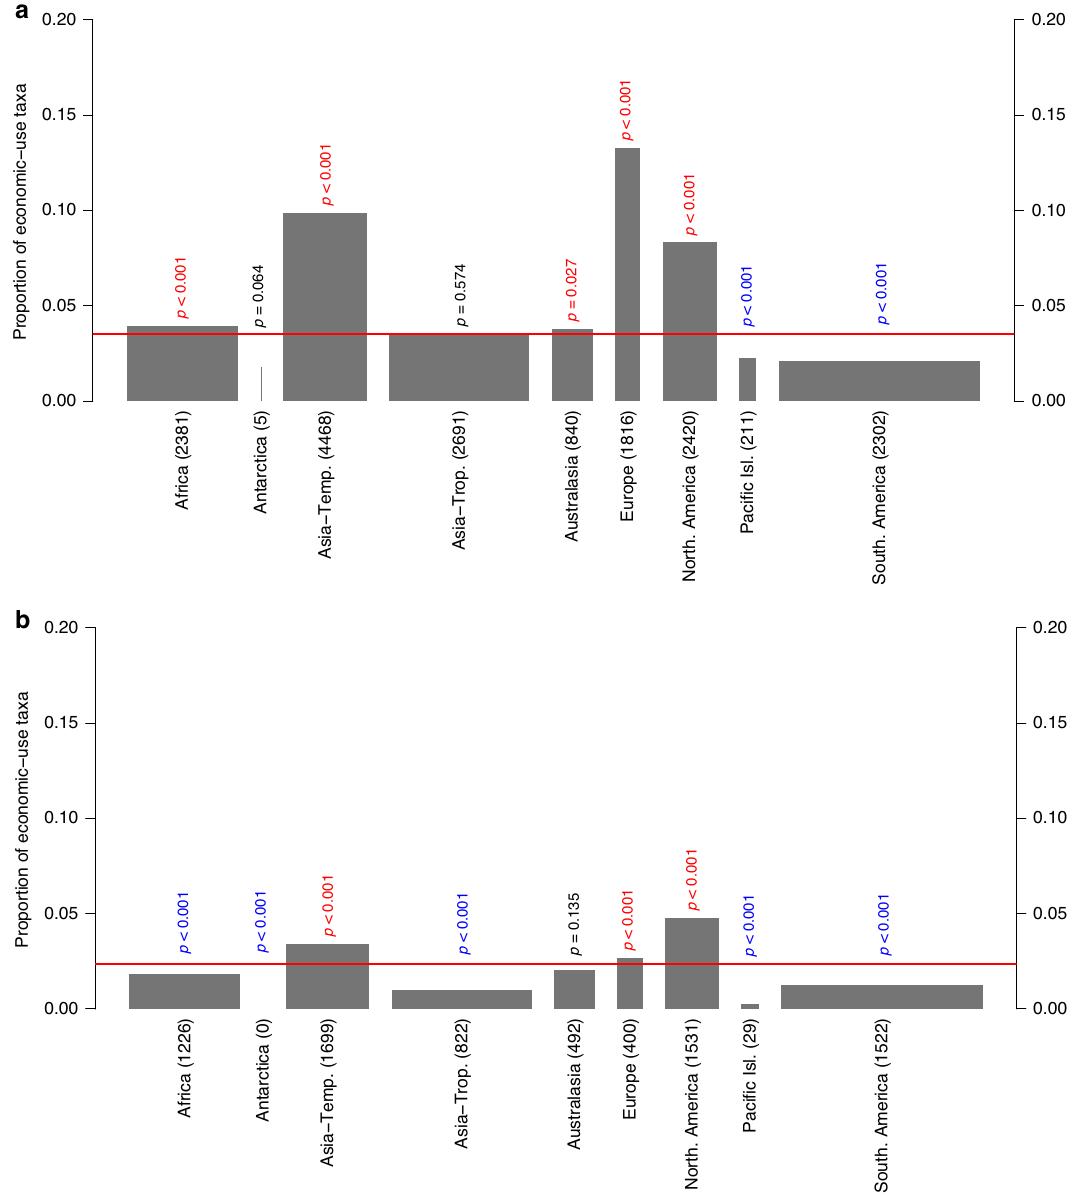
Fig. 5 Estimated proportions of native plants that have an economic use for each TDWG continent. Spineplots for ( a ) the taxa in the WEP dataset ( n = 11,485; excluding taxa only known from cultivation) and ( b ) the subset of taxa with a single native TDWG continent ( n = 7721). The width of each bar is proportional to the number of taxa in each regional fl ora. The red horizontal lines indicate the proportion of taxa in the global fl ora that occur ( a ) in the WEP dataset (i.e., have an economic use) or ( b ) the respective subset of WEP taxa with a single native TDWG continent. P values from two-sided resampling tests indicate whether the proportion of naturalized taxa is signi fi cantly higher (red) or lower (blue) than expected or does not deviate from expectations (black). No corrections were made for multiple comparisons. The number of taxa with an economic use from each continent is indicated in